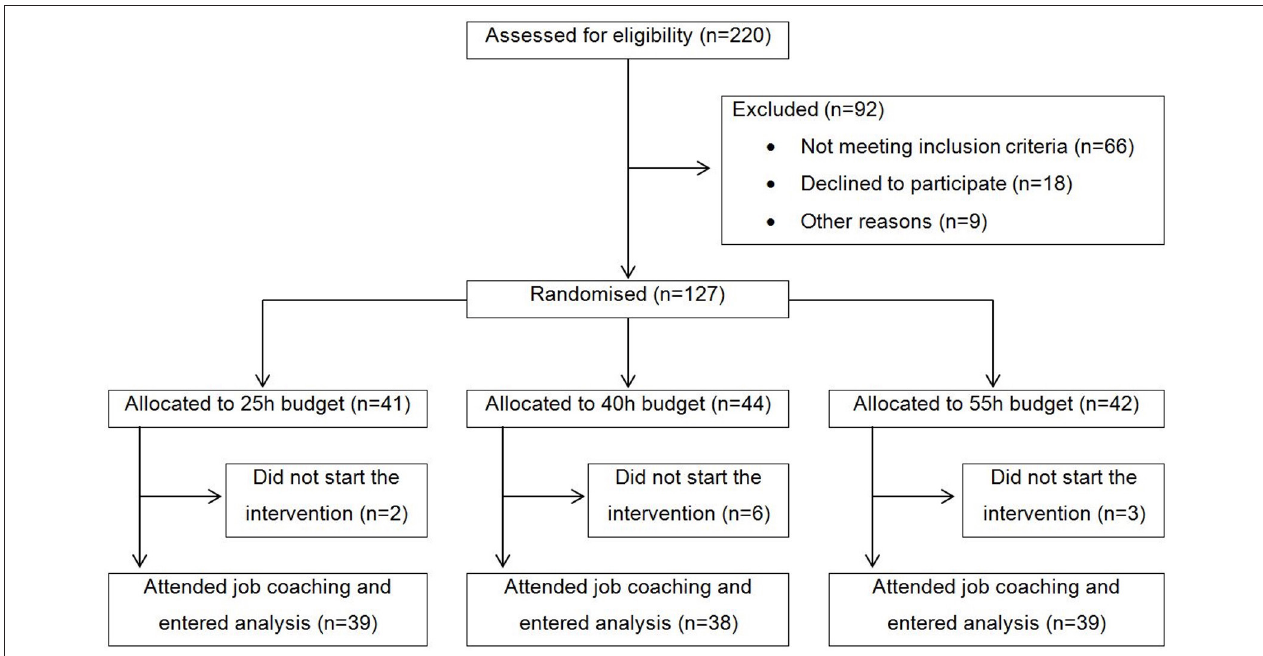
FIGURE 1 | Participant